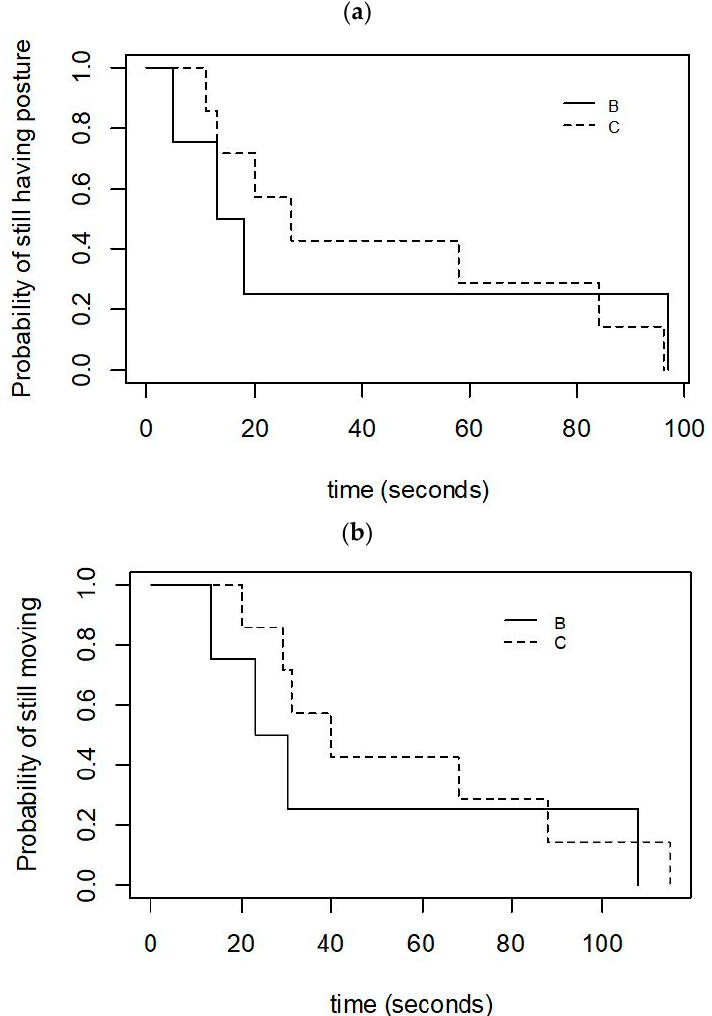
Figure 3. Kaplan–Meier graphs of ( a ) the latency to lose posture, and ( b ) the latency to cease moving in 11 calves that were successfully induced into a state of reduced responsiveness with either the cuff or the rope, and that did not have the squeeze discontinued for health reasons. Category C calves ( n = 7) maintained a state of reduced responsiveness for the full 10-min squeeze period, whereas the squeeze was discontinued in Category B calves ( n = 4).